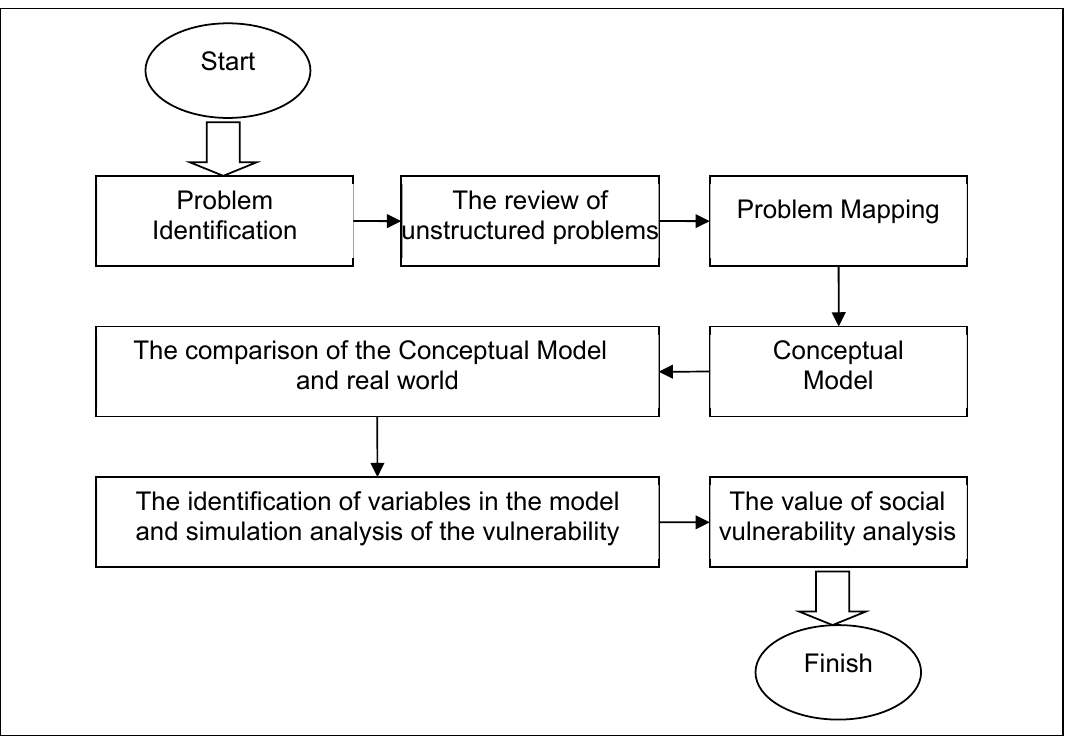
Fig. 4. The Flowchart of the